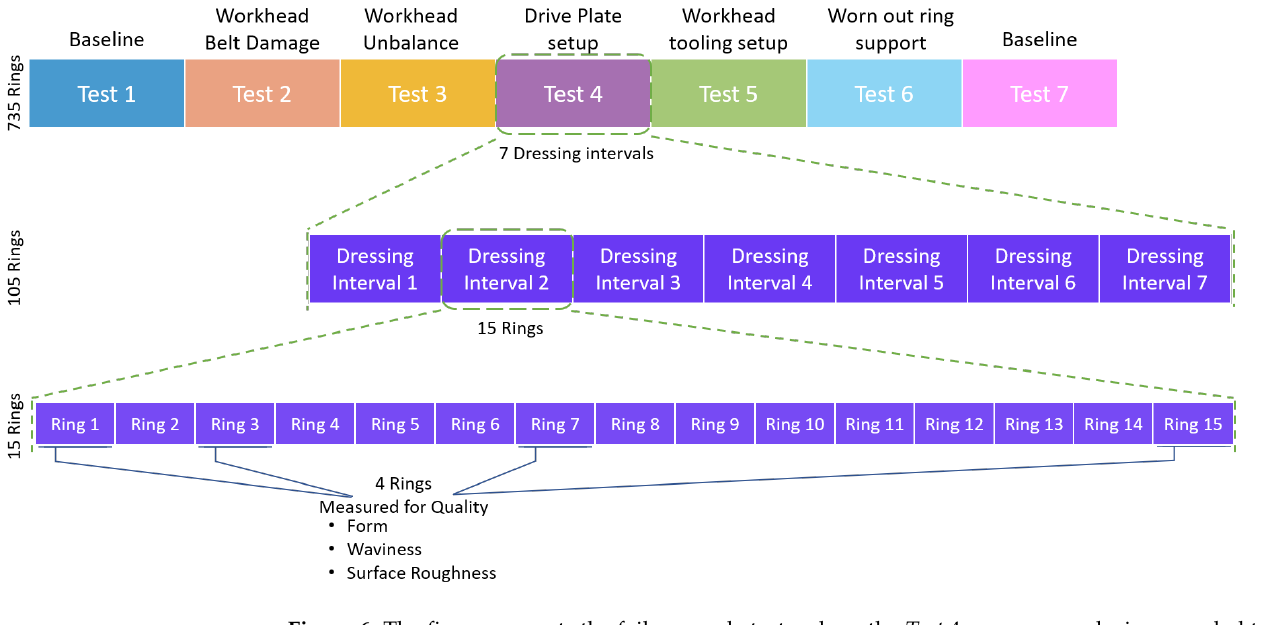
Figure 6. The figure presents the failure mode tests where the Test 4, as an example, is expanded to depict the test procedure with dressing intervals and the rings in each of the dressing intervals. This gives a total of 105 rings produced for each